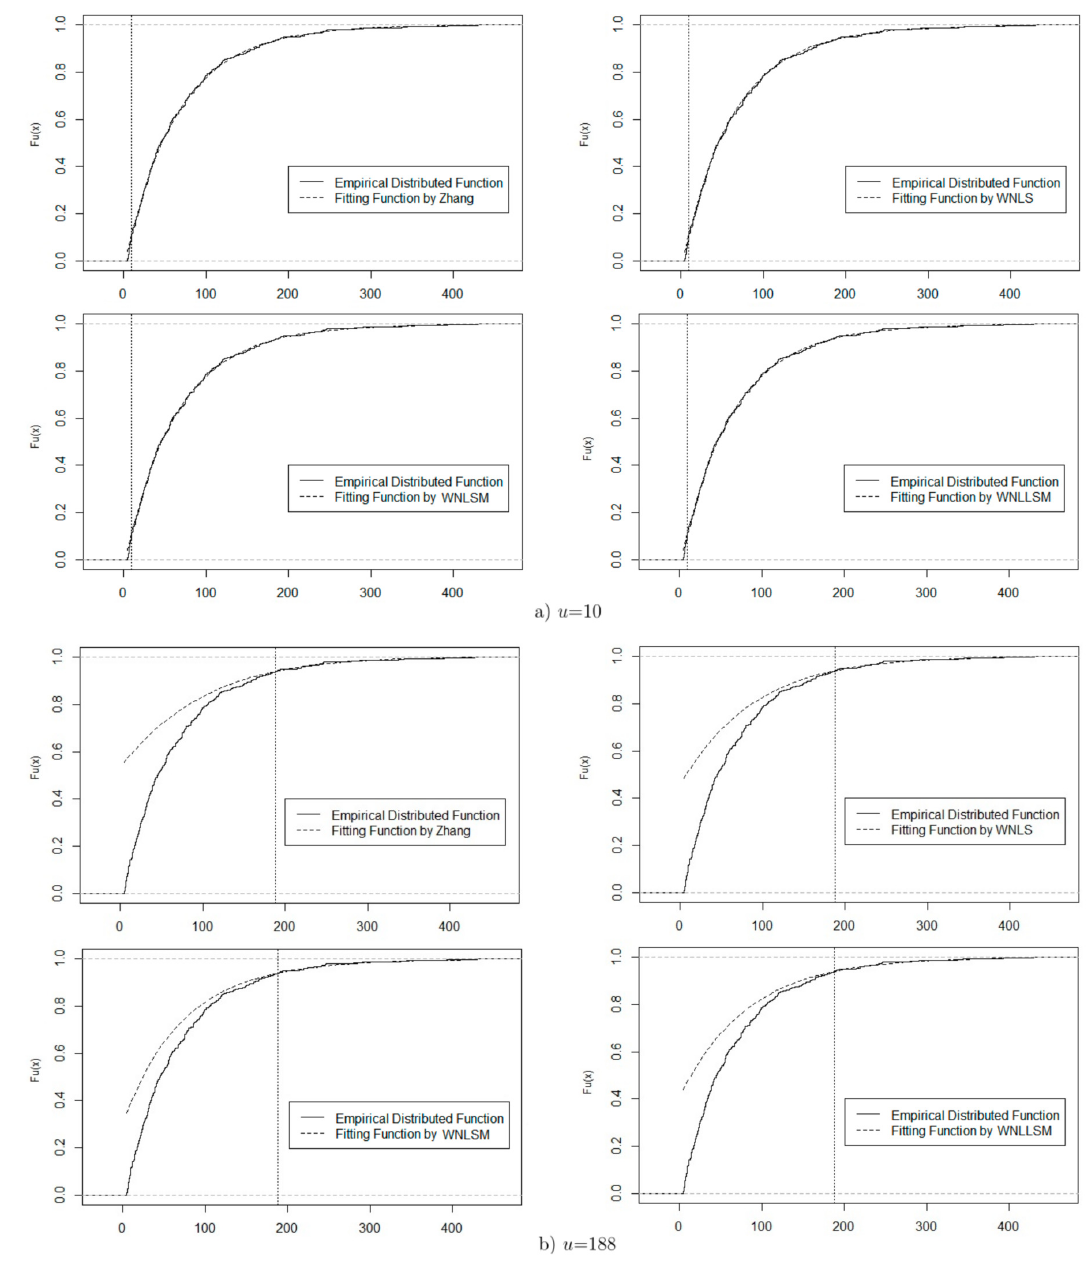
Figure 3. The GPD fitting plots for Beijing’s daily PM2.5